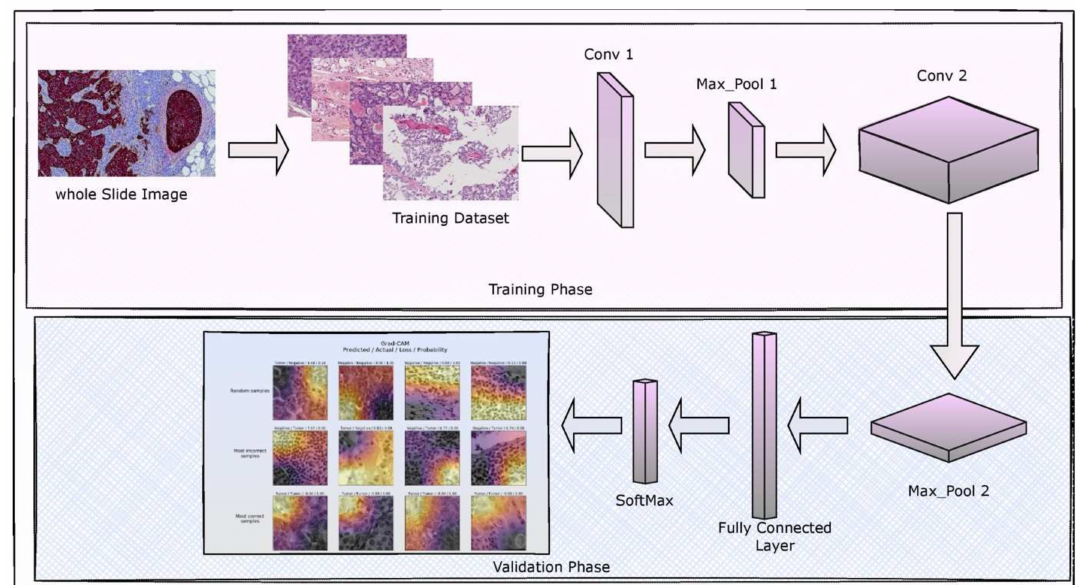
Figure 1. Image denoting the block diagram of the proposed model.